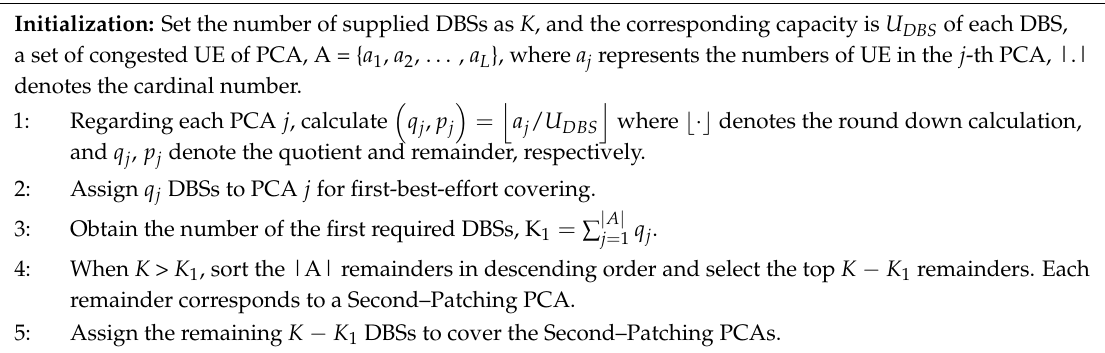
Algorithm 2. First-Best-Effort and Second-Patching algorithm (FBE–SP) Initialization: Set the number of supplied DBSs as K , and the corresponding capacity is U DBS of each DBS, a set of congested UE of PCA, A = { a 1 , a 2 , . . . , a L }, where a j represents the numbers of UE in the j -th PCA, |.| denotes the cardinal number.